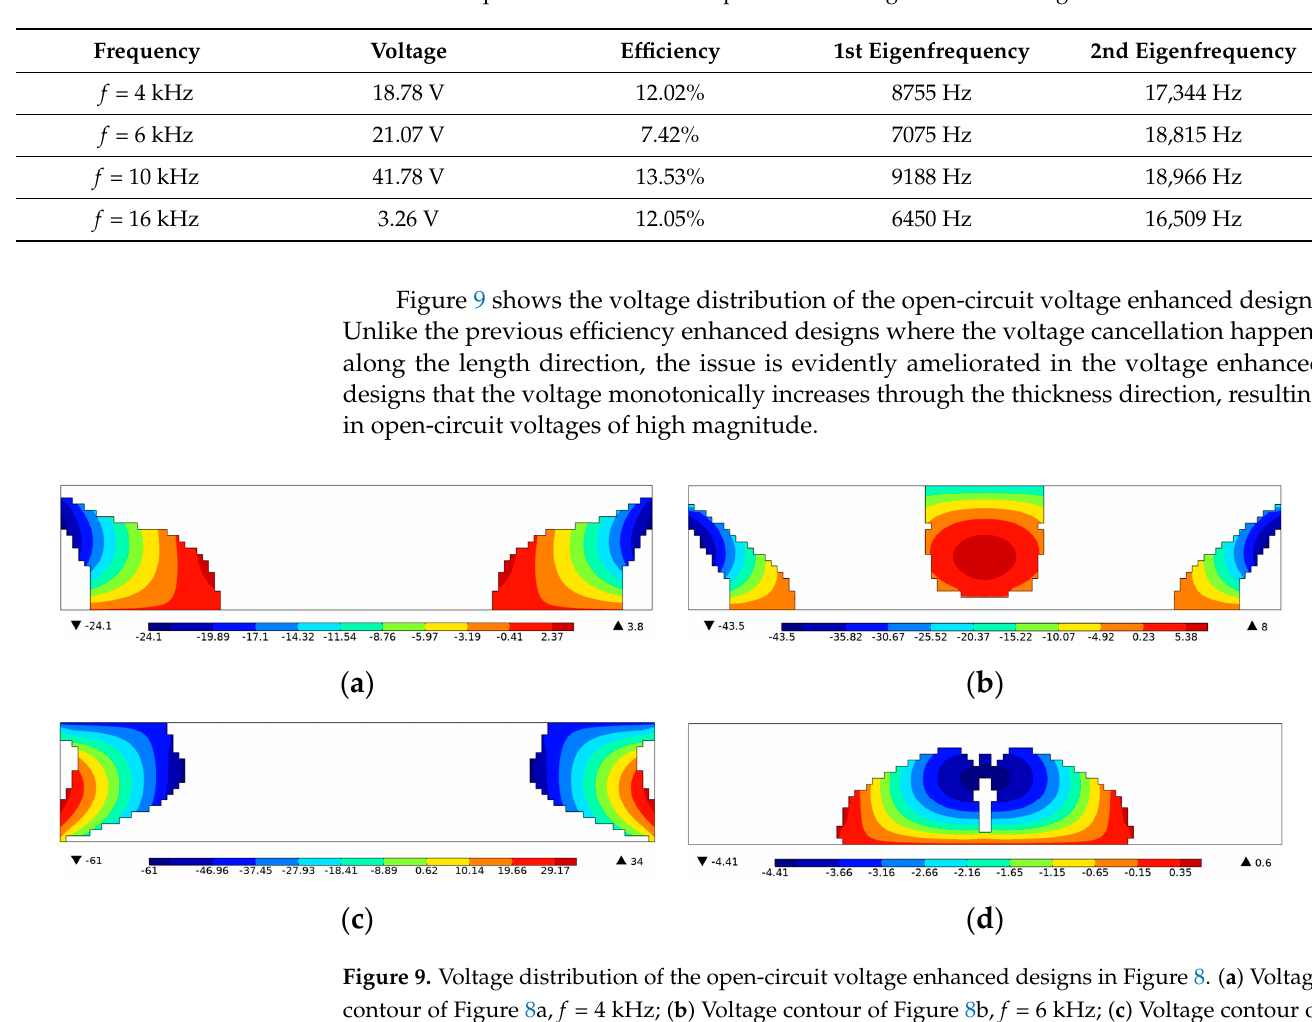
( b ) Figure 10. Iterative history and topological evolution for open ‐ circuit voltage designs. ( a ) f = 4 kHz; ( b ) f = 16 kHz. The frequency response results of the open ‐ circuit voltage and energy conversion efficiency for the designs obtained under excitation frequencies of 4 kHz and 16 kHz are compared in Figure 11. The first two eigenfrequencies of the original design in Figure 2 are 7088 Hz and 16121 Hz. As PZT ‐ 5A material has a comparable modulus to the substrate, the newly designed harvesters dynamically behave similarly to the original